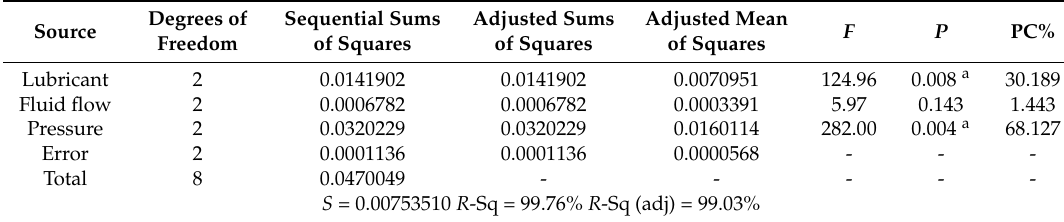
Figure 2. The effect of MQL parameters on surface roughness.